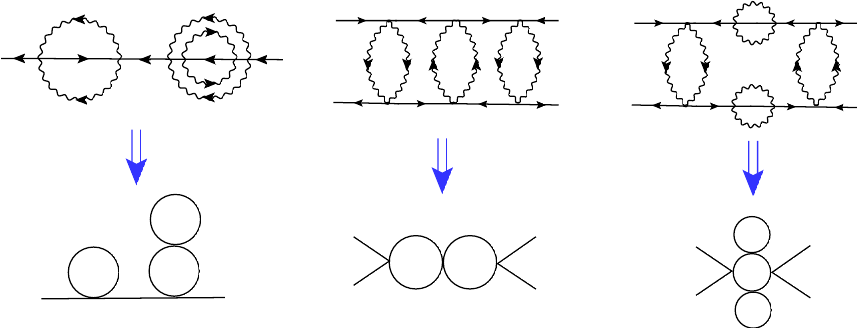
Figure 4 . Mapping the melonic diagrams of the model (2.1) onto the bubble diagrams of the vector model in the limit J (cid:28) M . Here we have assumed a (small) mass term for the vector fermion. If this is not the case, the snail diagrams in the vector model and the corresponding diagrams in the model (2.1)